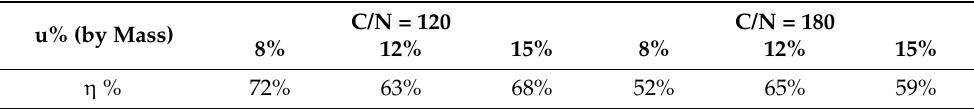
Table 6. Diesel oil removal efficiency η by microcosms with C/N = 120 and 180 at t = 138 days. u% (by Mass)